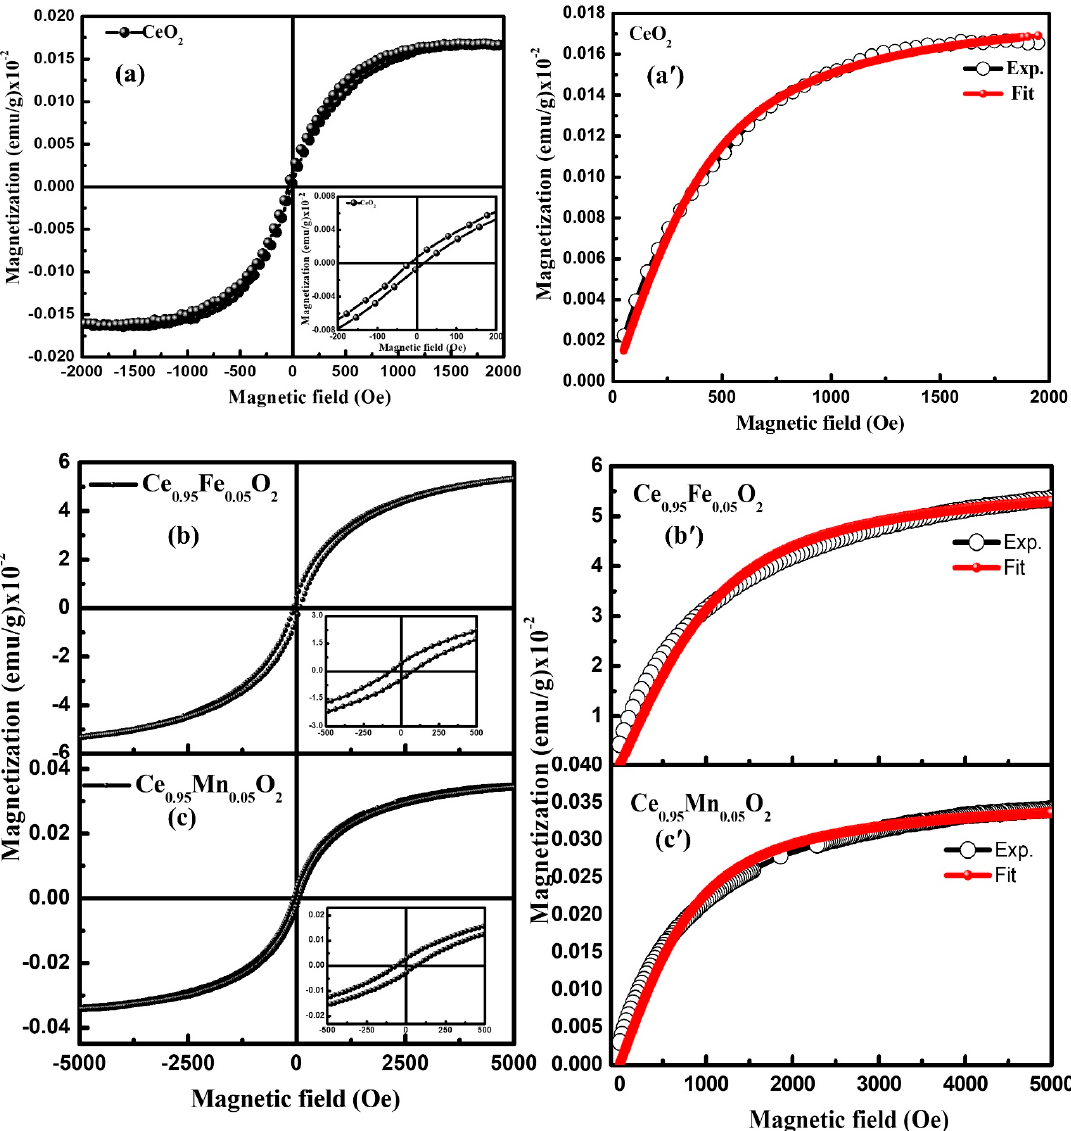
Figure 6. ( a – c ) MH hysteresis loops for undoped CeO 2 and Ce 0.95 X 0.05 O 2 (X: Fe, Mn) nanoparticles; ( a ′ – c ′ ) Fitting of M ‐ H loops using Langevin function to find BMP and matrix contribution to the ferromagnetic behavior.